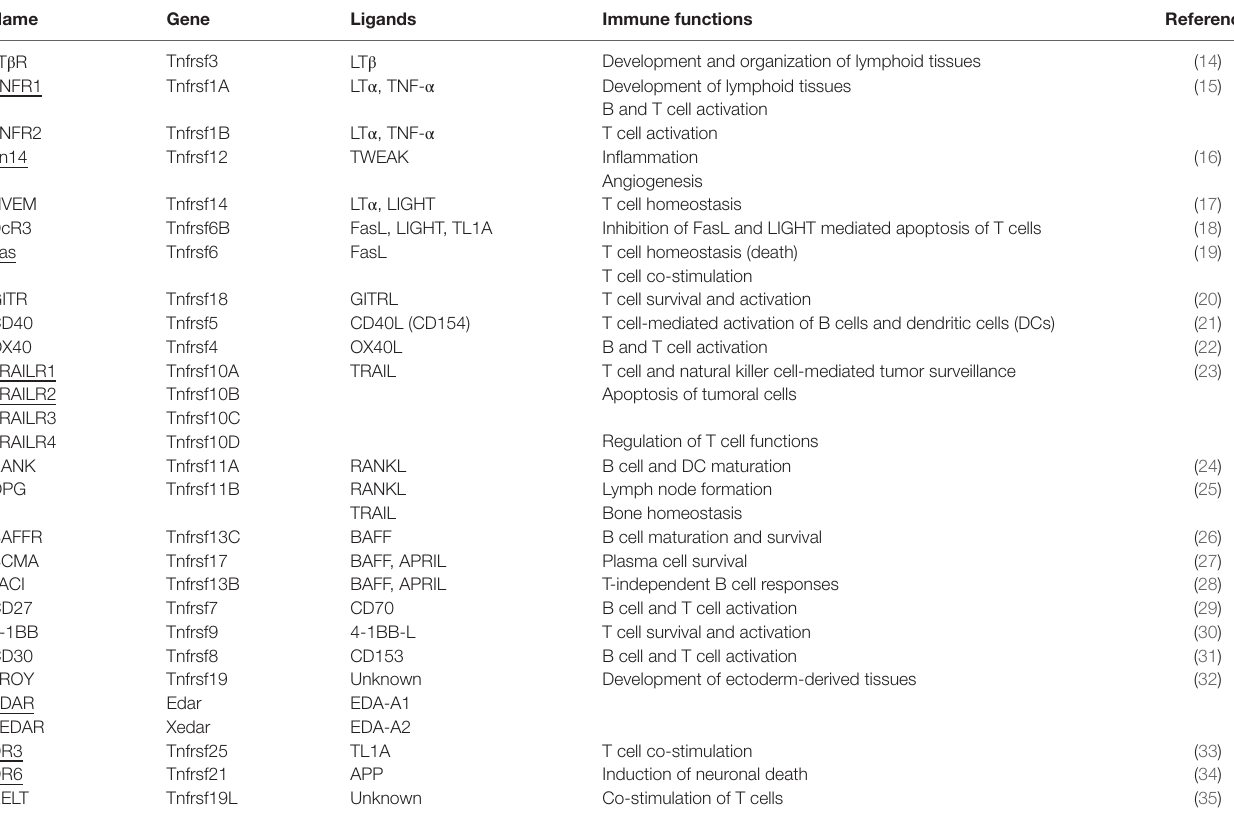
TaBle 2 | Functional relation of the tumour necrosis factor receptor superfamily (TNFRSF) and their cognate ligands